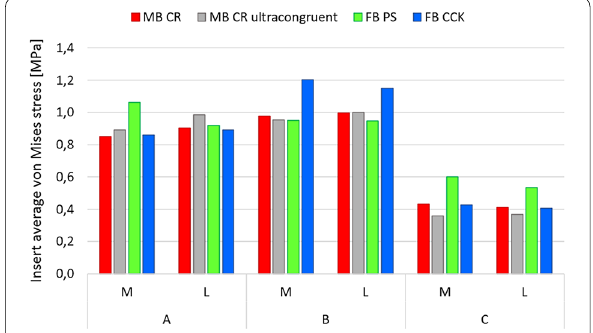
Fig. 8 Medial (M) and lateral (L) average polyethylene von Mises stresses for the different models in the three studied